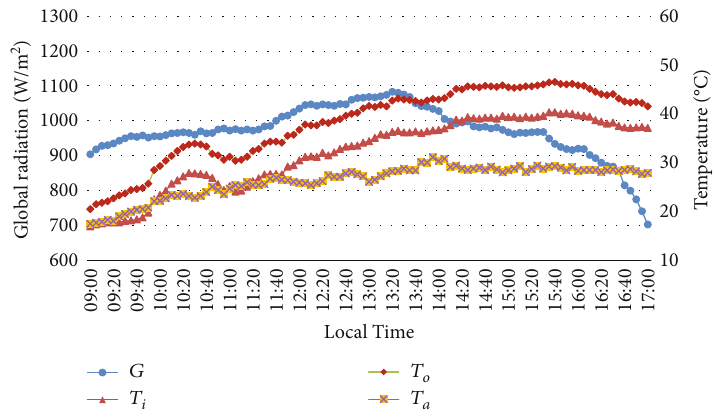
Figure 9: Solar radiation and temperature graphs for Al